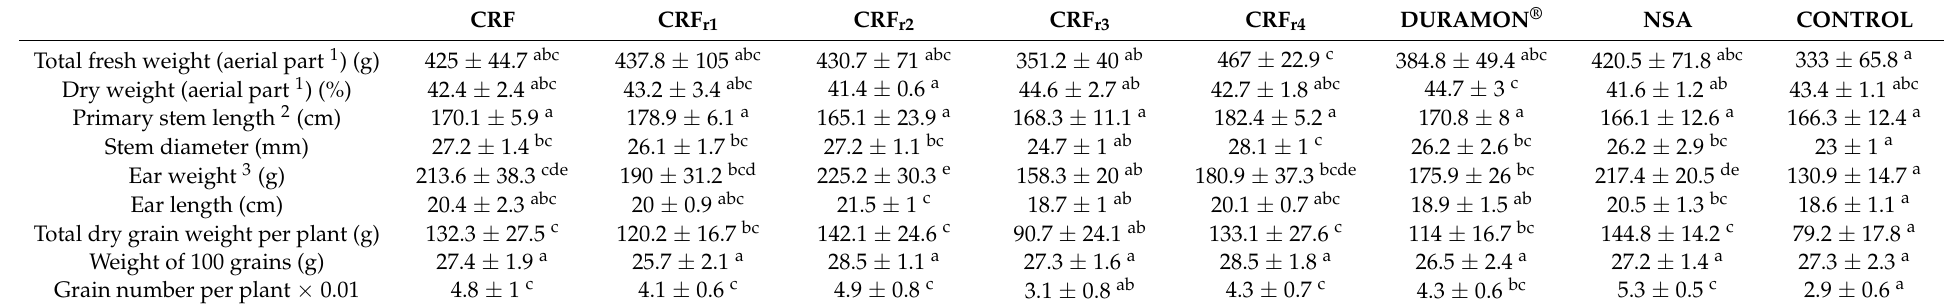
Table 3. Comparison of growth parameters between fertilizer treatments applied (CRF and their reductions, DURAMON ® , NSA) compared to CONTROL in the microscale experiment (CRF, DURAMON ® and NSA: 350 kg ha − 1 ; CRF r1 : 315 kg ha − 1 ; CRF r2 : 280 kg ha − 1 ; CRF r3 : 245 kg ha − 1 ; CRF r4 : 210 kg ha − 1 ). Values are means ± SD ( n = 12) at the end of the culture.